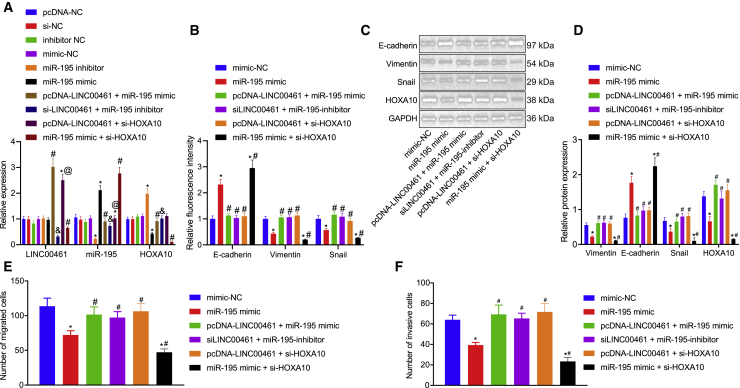
The LINC00461/miR-195/HOXA10 axis mediates the EMT process in HNSCC(A) The expression of LINC00461, miR-195 and HOXA10 in the FADU cells. (B) Statistical graph of the expression of EMT-related factors E-cadherin, N-cadherin, and Vimentin in the FADU cells. (C) Protein bands of EMT-related factors E-cadherin, N-cadherin, and Vimentin in the FADU cells. (D) Quantitative analysis of (C). (E) Transwell assay showing the migration ability of the FADU cells. (F) Transwell assay showing the invasion ability of the FADU cells. All of the data were measurement data expressed as means ± standard deviations. The data among multiple groups were compared using 1-way ANOVA. The experiment was conducted 3 times independently. ∗p < 0.05 versus the mimic-NC group. #p < 0.05 versus the miR-195 mimic group. &p < 0.05 versus the miR-195-inhibitor group. @p < 0.05 versus the pcDNA-LINC00461 + miR-195 mimic group.